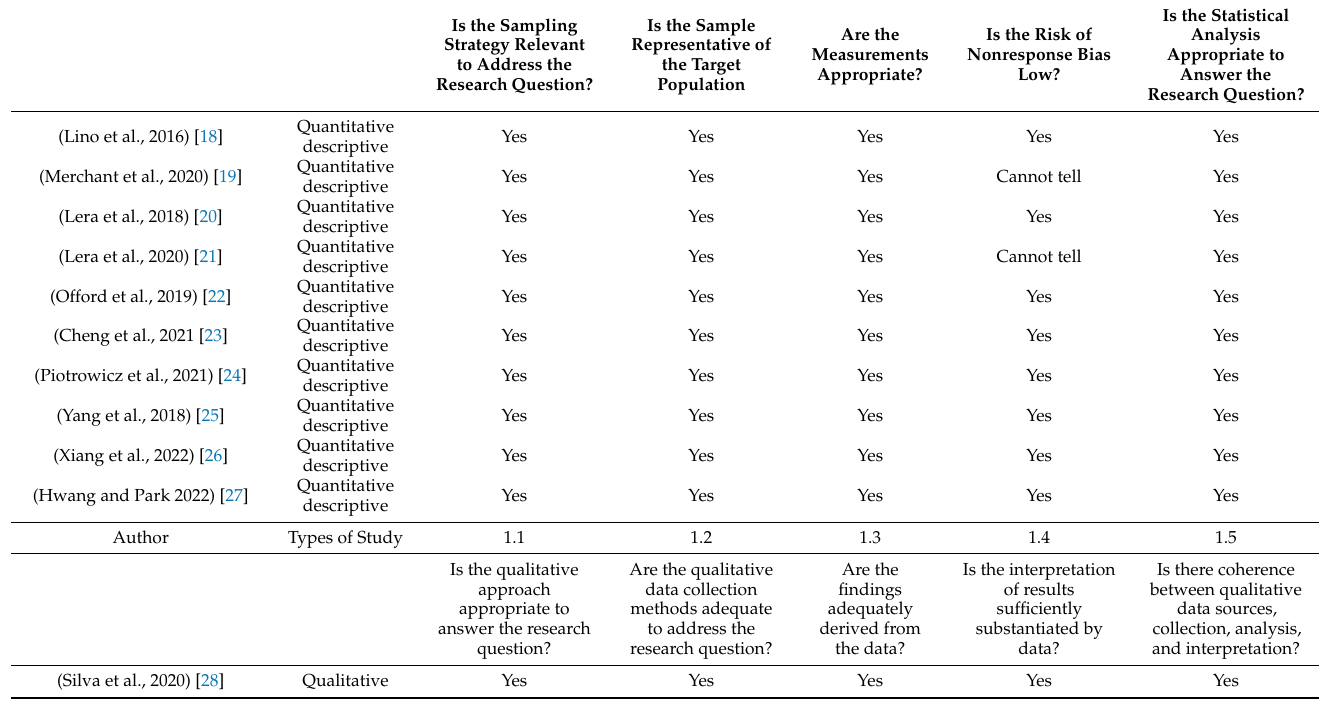
Table 2. The details of the MMAT assessment.